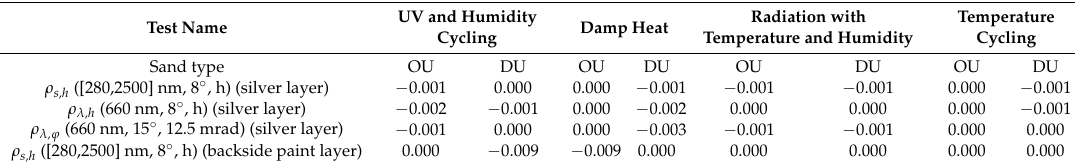
Table 3. Results of reflectance differences from the first set of samples, after the extended weathering tests. OU: Ouarzazate; DU: